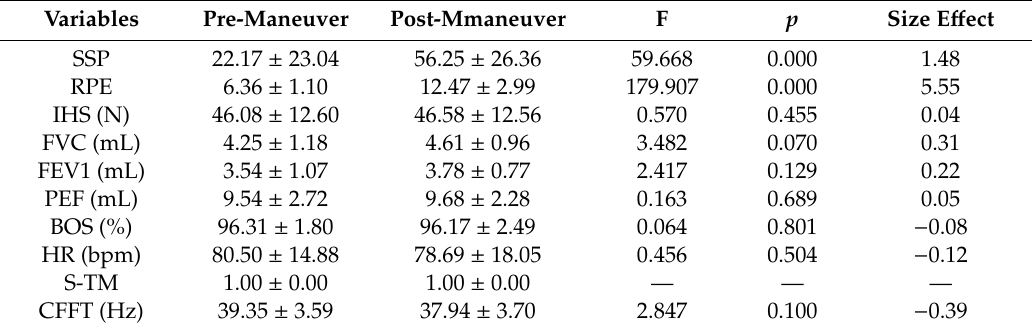
Table 1. Changes mean and standard deviation (M ± SD) in psychophysiological variables pre- and post-maneuver.